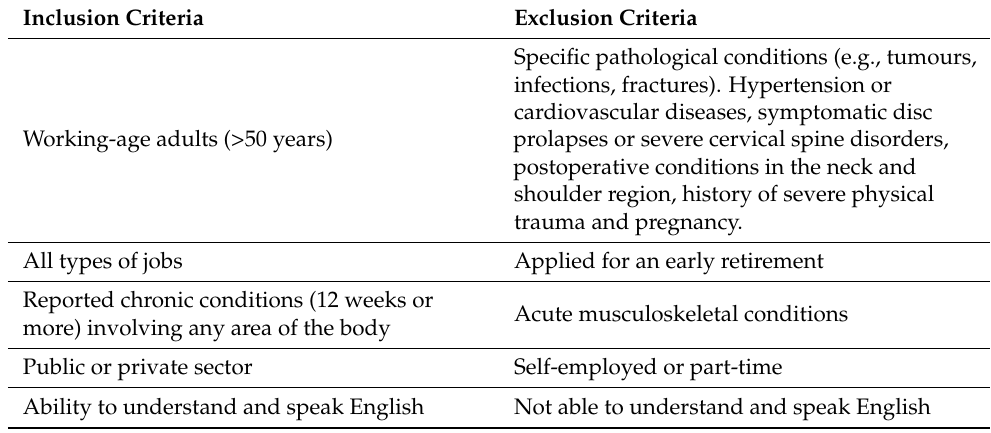
Table 1. Inclusion and exclusion criteria for the participants and